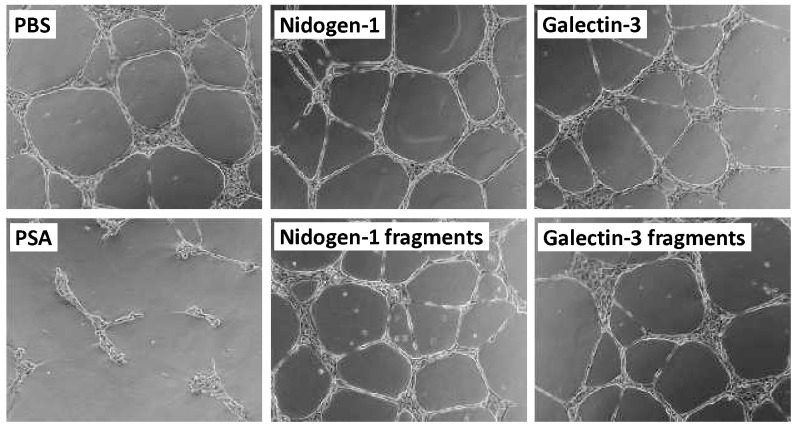
HUVEC tube formation assay with nidogen-1 and galectin-3.Nidogen-1 and galectin-3 or their PSA-generated fragments did not have any effect on tube formation. Control wells are with PBS and PSA. Images are representative examples from two separate experiments.